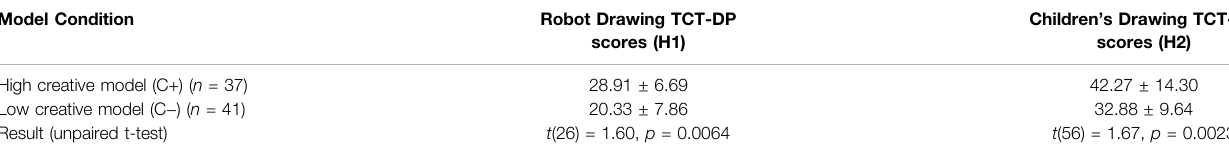
TABLE 3 | MAGICDRAW fi gural creativity game one-way ANOVA results per condition for each study hypothesis. Model Condition